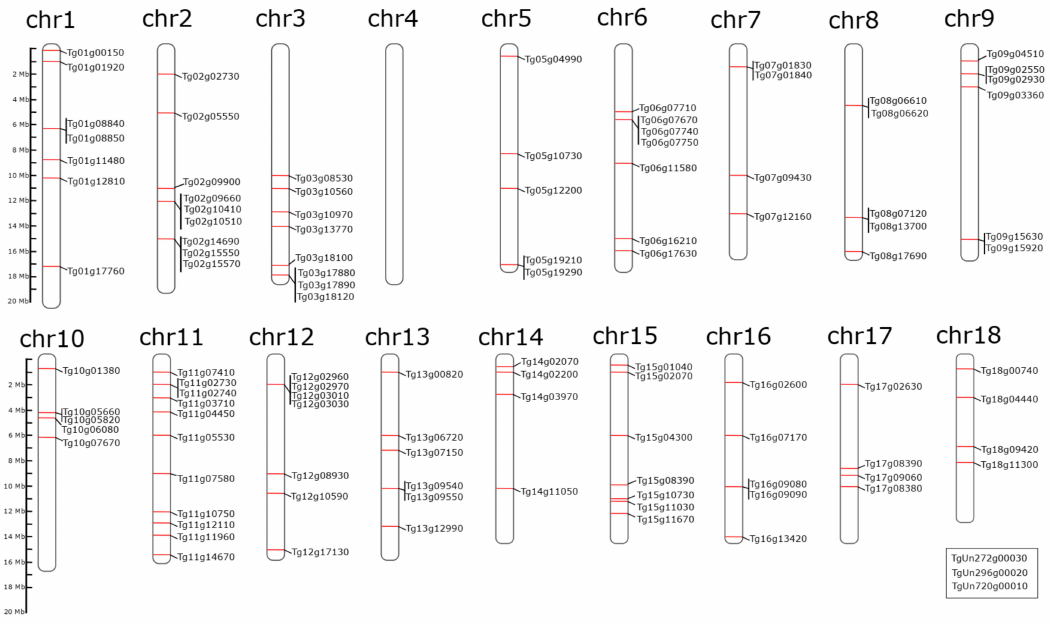
Figure 3. Location and distribution of 107 TgNAC genes on 18 T. grandis chromosomes. The box at the bottom right-hand side represents three TgNAC genes that were not placed within any of the chromosomes and were present in orphan sca ff olds. TgNAC genes were mapped according to their genomic position in the pseudomolecules (Table S5). The scale on the left-hand side is represented by megabase